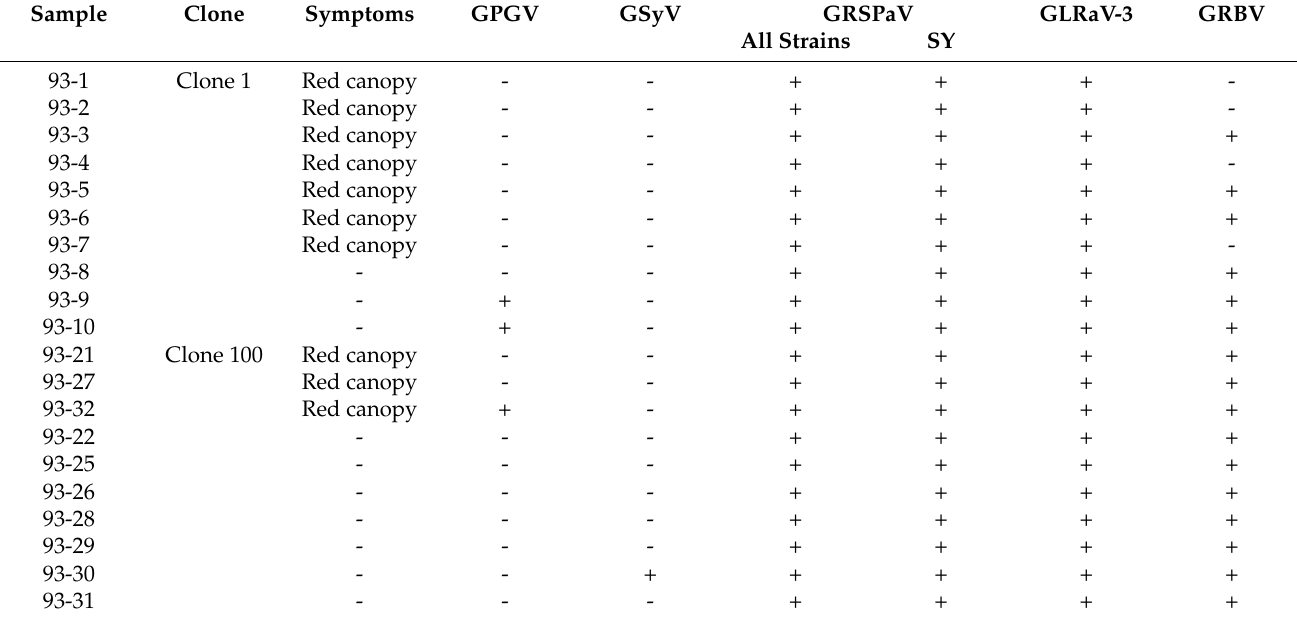
Table 3. RT-PCR and RT-qPCR detection of viruses from Syrah vines with and without Syrah decline symptoms. All vines tested also had symptoms of infection with